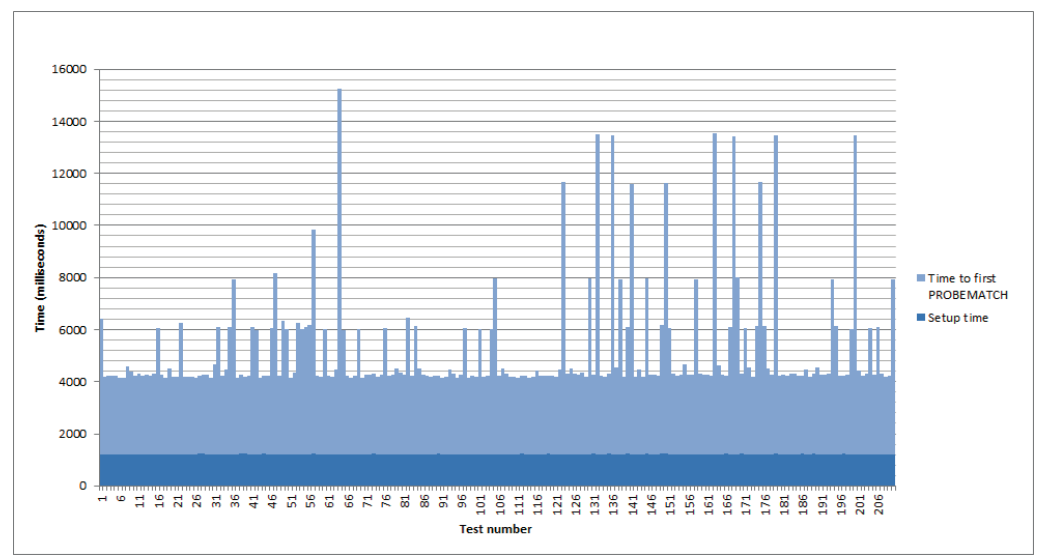
Figure 7. Time to event source